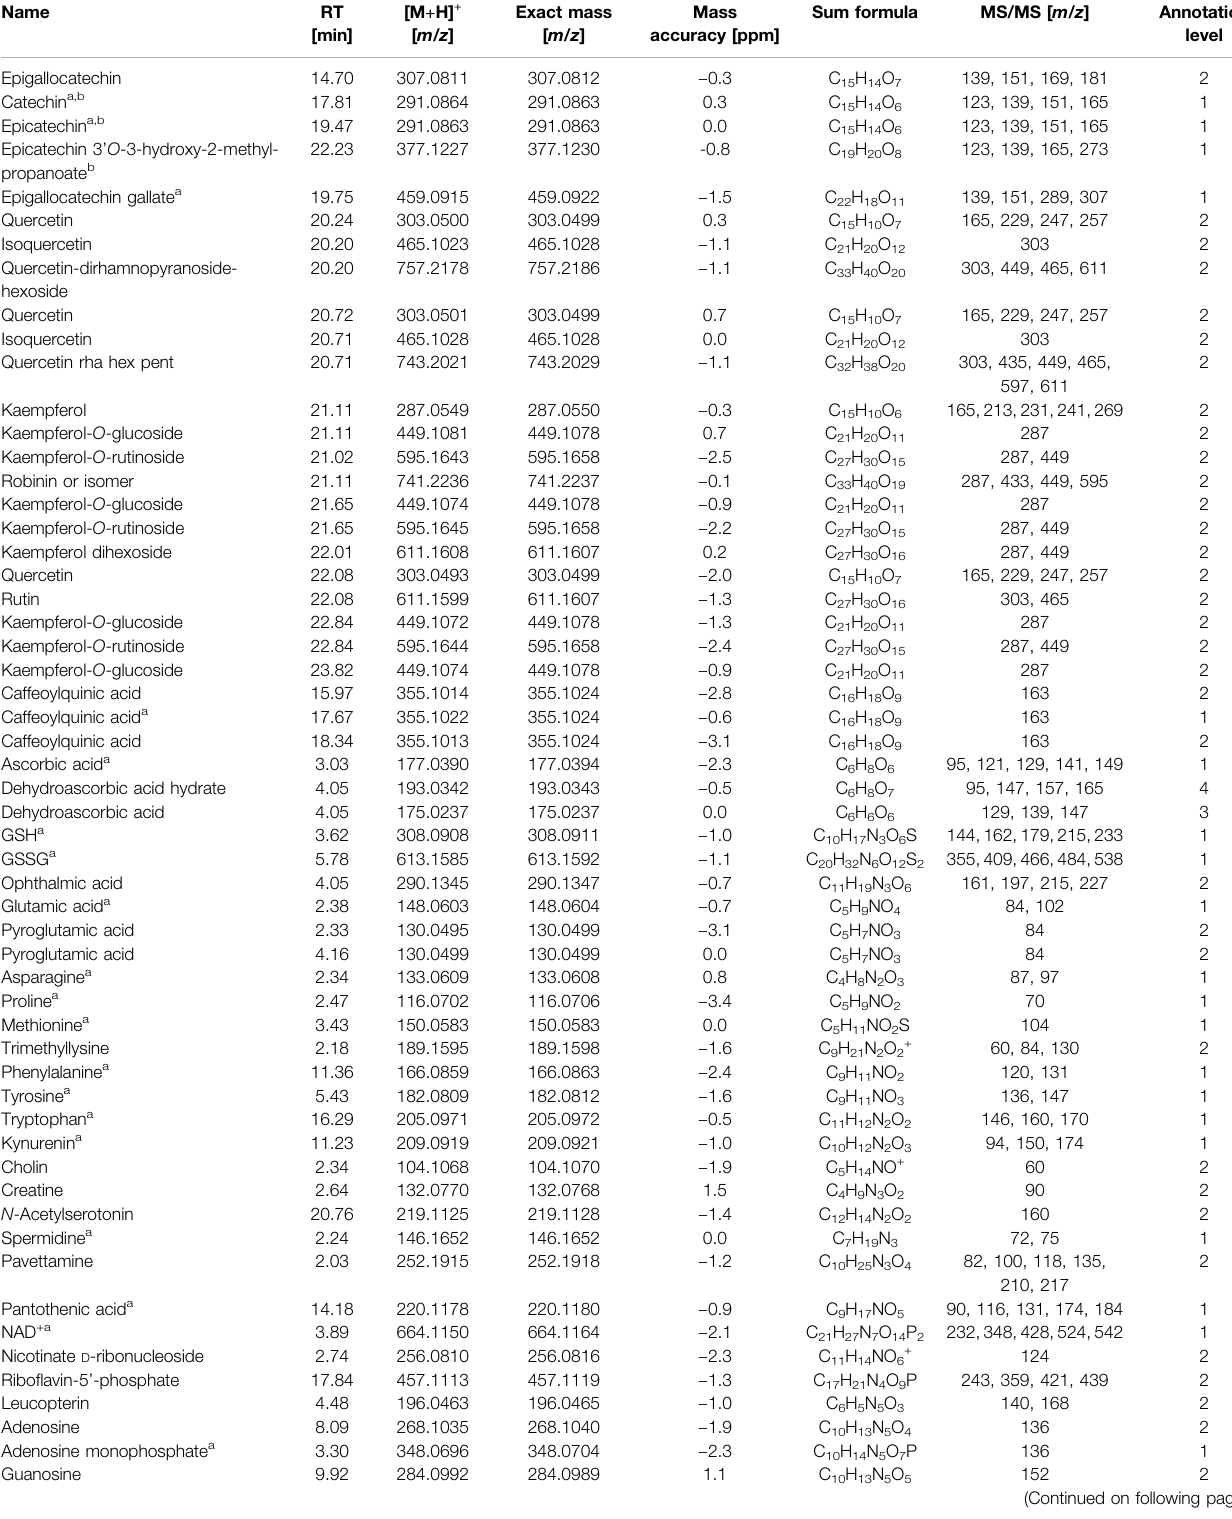
TABLE1| Tableofannotated m/z featuresdetectedwithinleafextractsofnodulatedandlaminatissuesof Ardisiacrenata and Psychotriapunctata measuredbyLC-MS/MS.